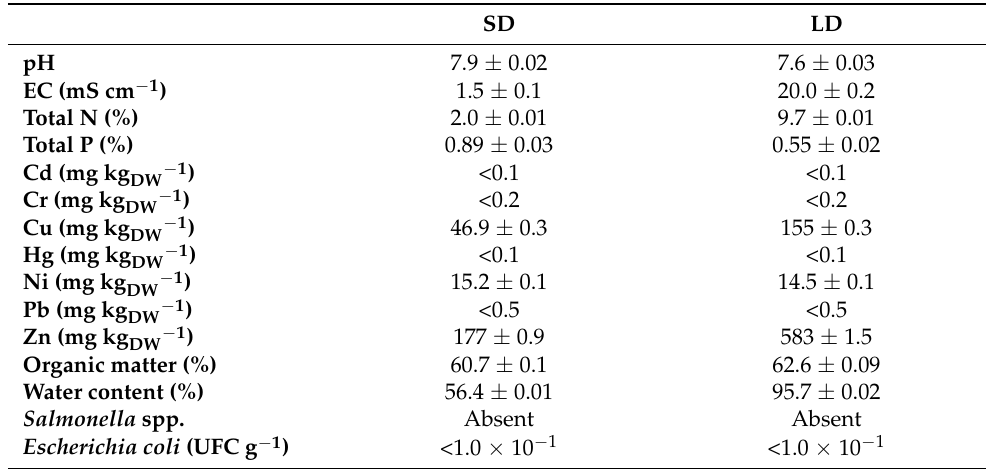
Table 1. Chemical and microbiological characteristics (mean ± standard error) of the solid (SD) and liquid digestate (LD) used in this study. pH and electrical conductivity (EC) were determined in a ratio of 1:20 ( w / v ) for the SD, while pH and EC were determined in the LD. SD